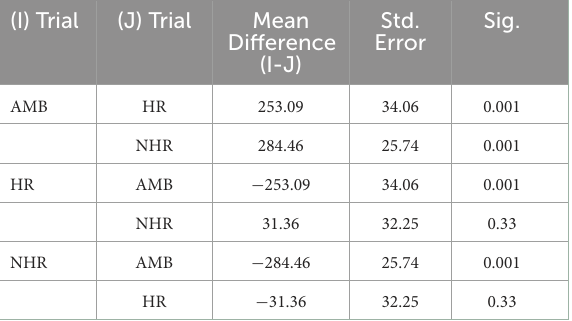
TABLE 3 Results of pairwise comparisons for reaction time to interpretation bias task trials for all participants ( n =